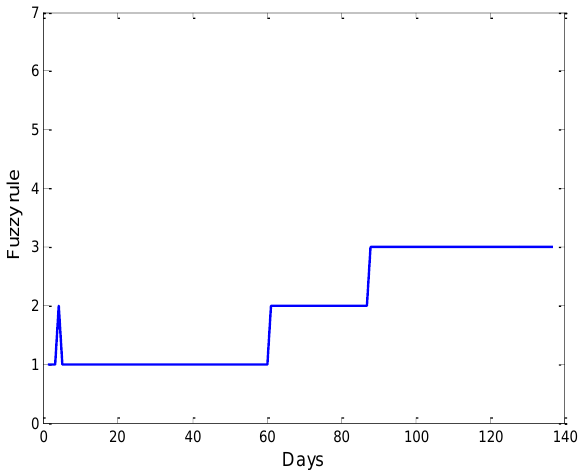
Figure 13. Fuzzy rule evolution of histogram lower feature.